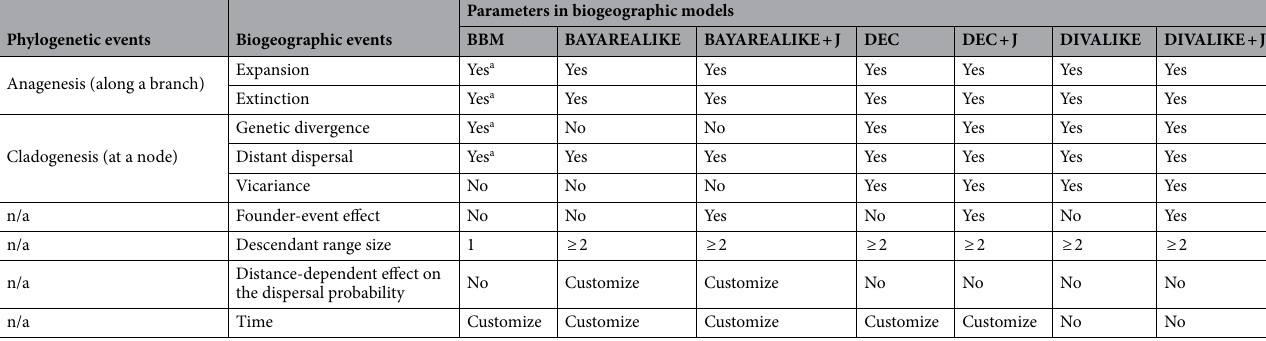
Table 1. Phylogenetic and biogeographic events considered in seven biogeographic models used for analysis. Expansion (dispersal), extinction, and founder events are modeled through d , e , and J parameters, respectively. BBM infers ancestral ranges with biogeographic processes being annotated in RASP (marked as a